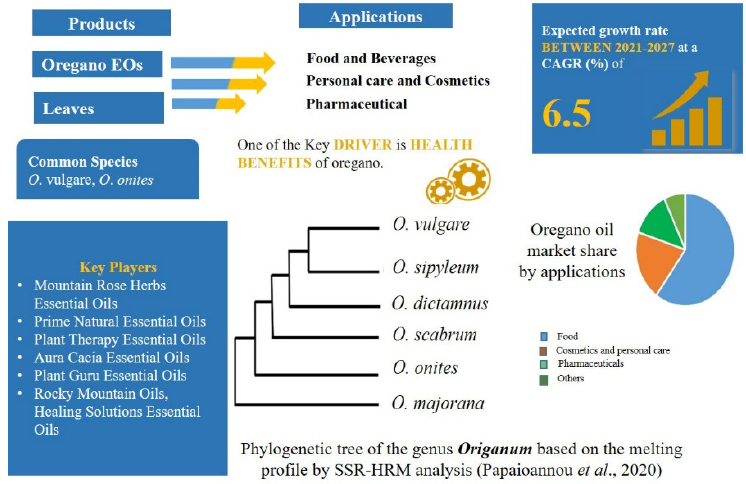
Figure 5. Oregano products market analysis [221] and phylogenetic relationship among the species.